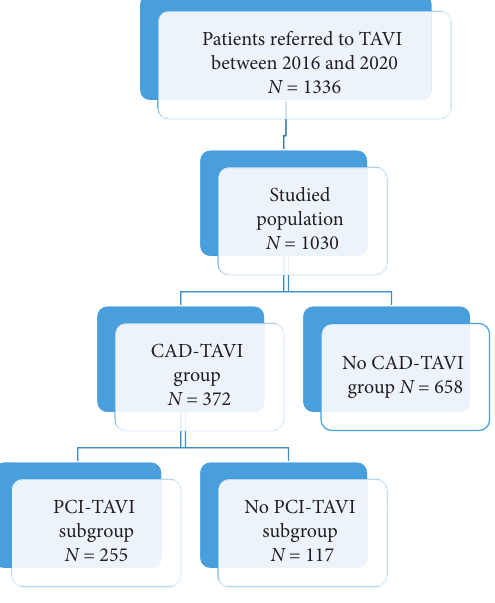
Figure 1: Study flow